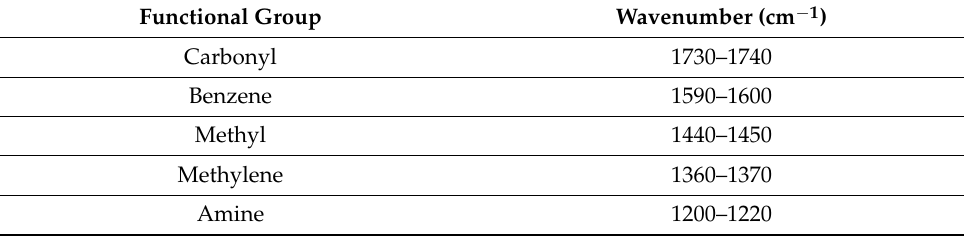
Table 3. Visible FR-IR spectra of